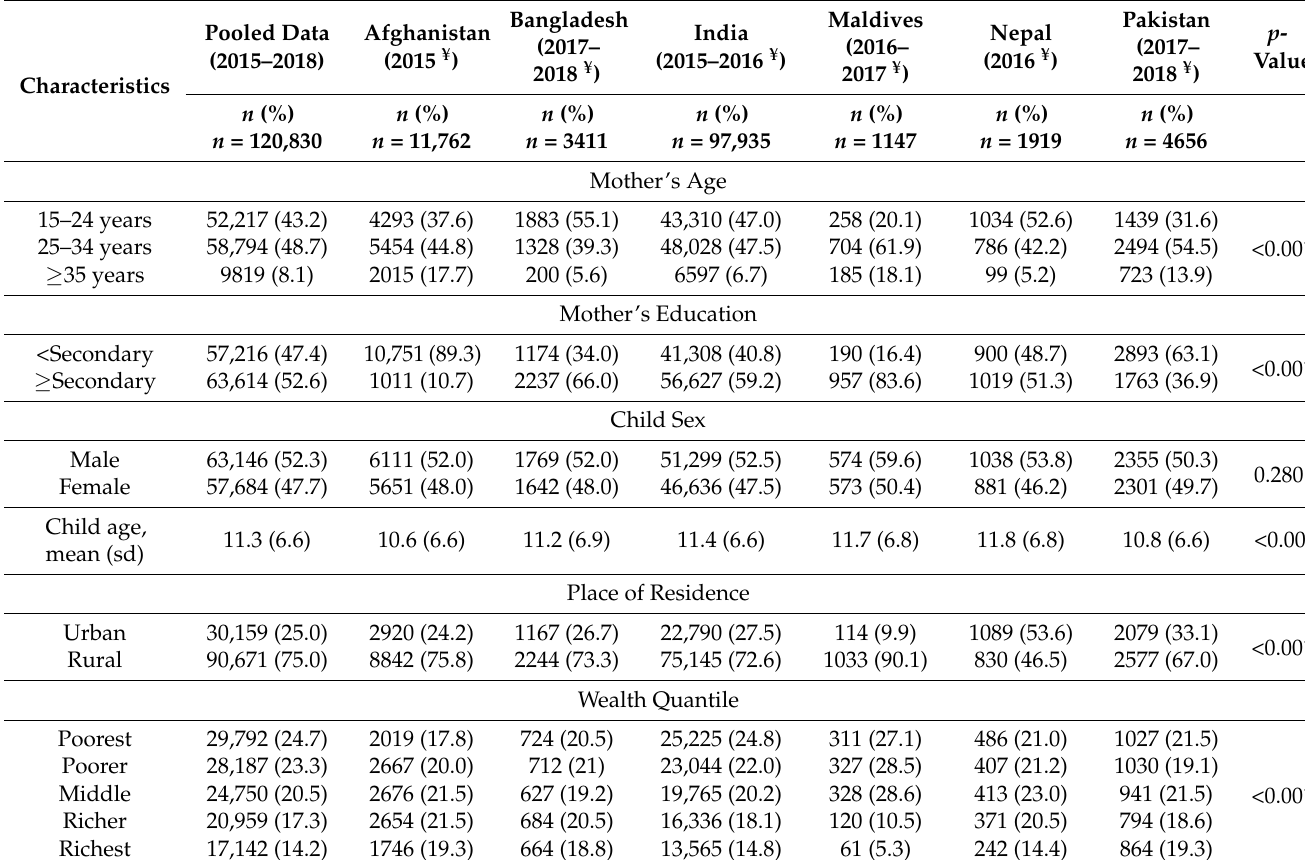
Table 1. Socio-demographic characteristics of the study